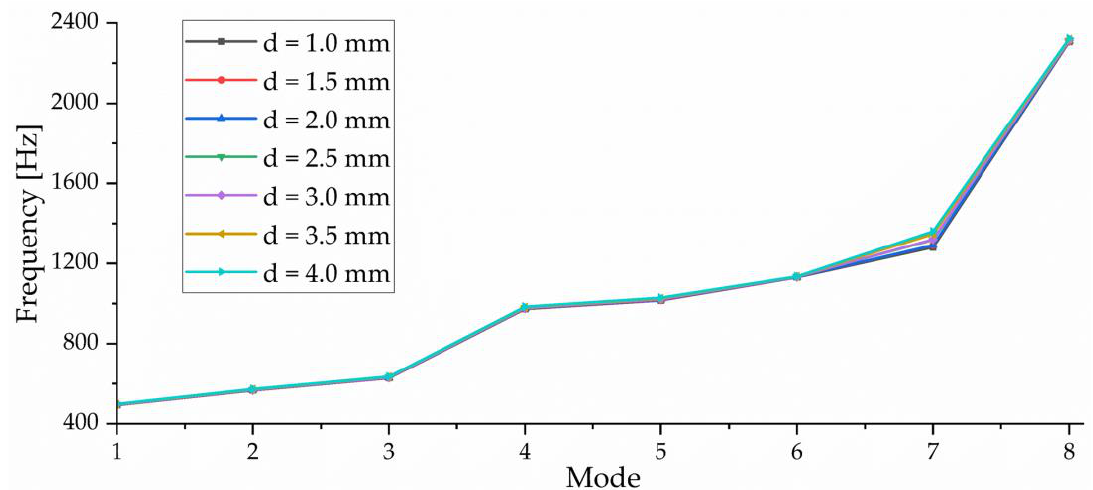
Figure 6. Mesh convergence study.